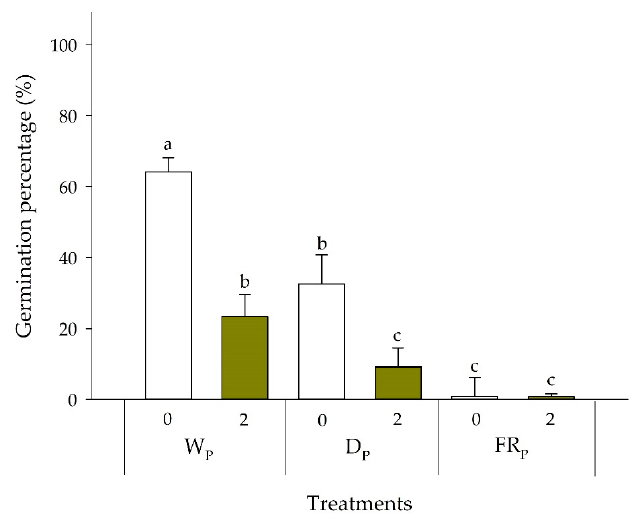
Figure 6. The seed germination percentage of Cobbler’s pegs treated with residues of 0 or 2 g DW plot − 1 under the white light (12-h photoperiod, W P ), darkness (D P ) or FR (12-h photoperiod, FR P ). The light intensities of white light (LED, 400–750 nm, 6500 k) and FR (LED, 730 nm) were 149 µmol m − 2 s − 1 and 0.71 µmol m − 2 s − 1 . The R/FR ratios of white and far-red LED light were 11 and 0.01, respectively. Error bars are the SE ( n = 4). The same letters indicate no significant difference at p < 0.05 by Fisher’s protected LSD test.